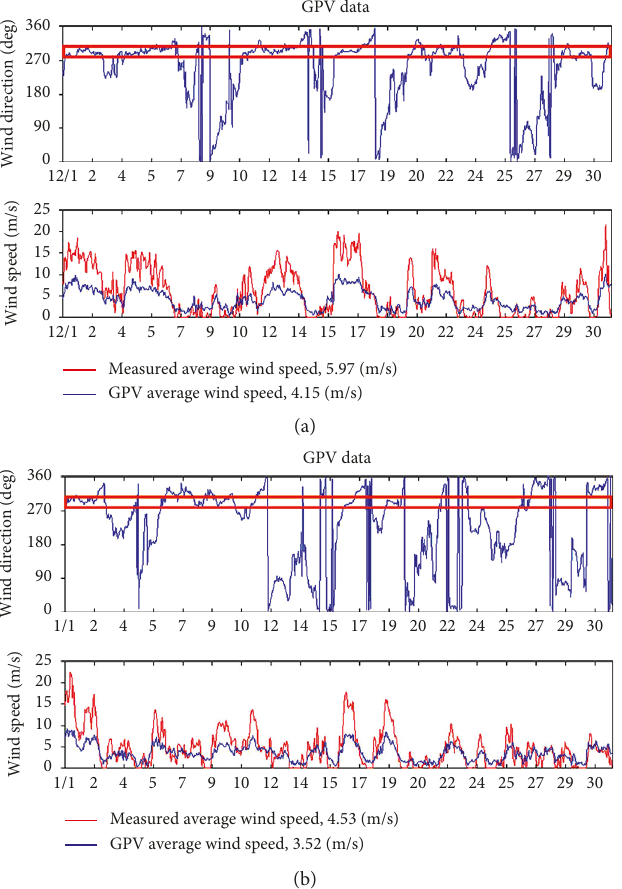
Figure 3: Comparison of measured data (5m above ground) and weather GPV data (10m above ground). (a) December 2014. (b) January